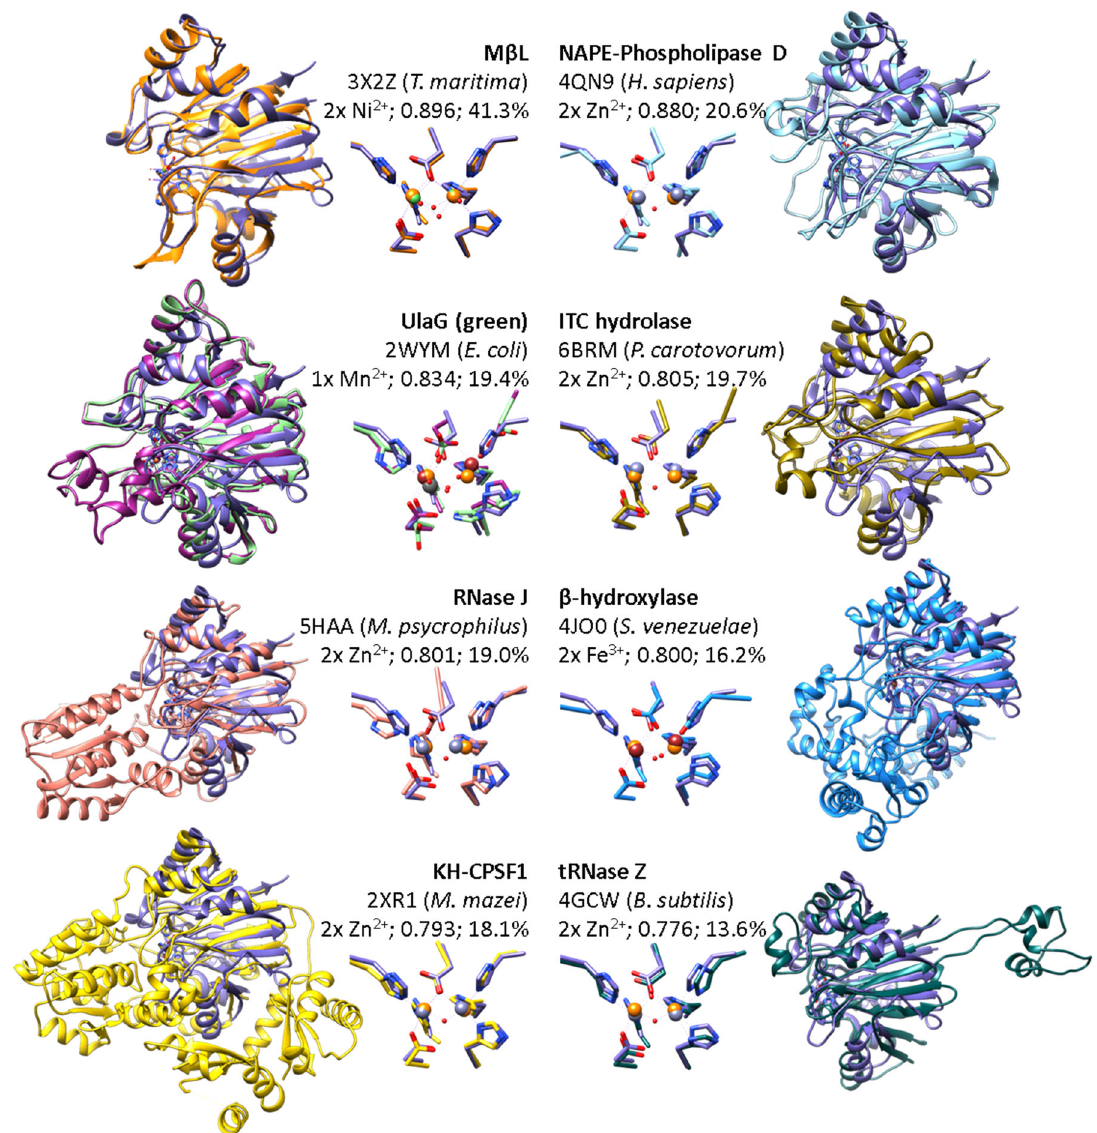
Fig. 2 Structural conservation of the Igni18-like core-domain within M β Ls with specialized activities. The homolog structures 3X2Z from Thermotoga maritima , 4QN9 from Homo sapiens , 3BV6 from Vibrio cholerae , 2WYM from Escherichia coli , 6BRM from Pectobacterium carotovorum , 5HAA from Methanolobus psycrophilus , 4JO0 from Streptomyces venezuelae , 2XR1 from Methanosarcina mazei , and 4GCW from Bacillus subtilis are shown. Igni18 is depicted in purple and its two Zn 2 + ions in orange. Enzymatic function, PDB code, source organism, metal ions bound, structural identity score (TM-score), and sequence identity [%] are indicated. The uncharacterized 3BV6 protein (2x Fe 3 + ; TM-score 0.8418; seq. id. 21.1 %) is shown in violet together with UlaG (in green) due to their high similarity and because of the completeness of its structure as opposed to UlaG ’ s. The catalytic pockets and amino acids necessary for metal coordination are shown in a close-up. Structure overlays are sorted by overall structure similarity (TM-score, Supplementary Data